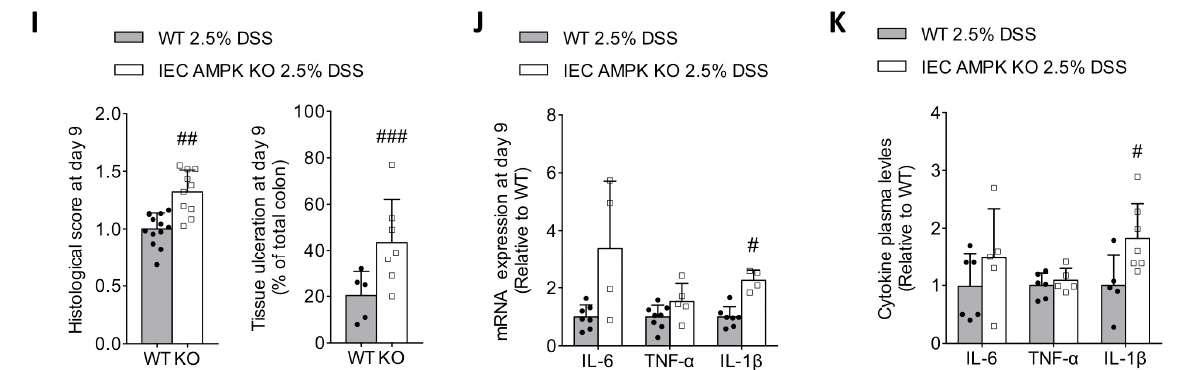
Figure 2. Absence of IEC AMPK delays intestinal epithelial recovery after DSS-induced injury. ( A ) Experimental timeline for 2.5% DSS-induced colitis in female WT and IEC AMPK KO mice. Mice were treated with 2.5% DSS in drinking water for five consecutive days, followed by six days of regular water. ( B ) Survival rate during the experimental period ( n = 36–41 mice/group). The results are pooled from three independent experiments. ( C ) Evolution of body weight during the progression of colitis induced by 2.5% DSS in WT and IEC AMPK KO mice ( n = 17–20 mice/group). The results are pooled from two independent experiments. ( D ) Colon length on day 10 following DSS challenge ( n = 4–8 mice/group). ( E ) In vivo paracellular intestinal epithelial permeability of WT and IEC AMPK KO mice on day 9 during 2.5% DSS-induced colitis protocol. Dextran flux was determined by measuring the amount of 4 kDa TRITC-dextran in the plasma 4 h after gavage. Data are presented as mean dextran flux fold change relative to respective control mice ( n = 6–7 mice/group). ( F ) Expression of mRNA for tight junction proteins occludin and ZO-1 in the distal colon of WT and IEC AMPK KO mice on day 9 of the recovery phase ( n = 5–8 mice/group). ( G ) Representative images of H&E-stained sections of Swiss-rolled colonic specimens (with proximal gut in the center and distal colon in the exterior) from IEC AMPK KO and WT mice on day 9. Pictures are representative of 10–13 mice/group. Ulceration is highlighted in blue. ( H ) Higher magnification images of colon sections. Scale bars = 50 µm. ( I ) Histological damage score ( n = 10–13 mice/group) and quantification of percentage of colon ulceration ( n = 5–7 mice/group). ( J ) Expression of mRNA and ( K ) plasma levels for pro-inflammatory cytokines Il-6, TNF- α and IL-1 β in IEC AMPK KO and WT mice on day 9 ( n = 5–7 mice). Data are expressed as means ± SD. Statistical analysis was performed by using a Student’s t test, non-parametric Mann–Whitney test, one-way ANOVA or two-way ANOVA with Bonferroni post hoc test; ** p < 0.01 and *** p < 0.001 indicate a significant difference relative to the untreated condition; # p < 0.05, ## p < 0.01 and ### p < 0.001 a significant difference between genotype; n.s., not significant.